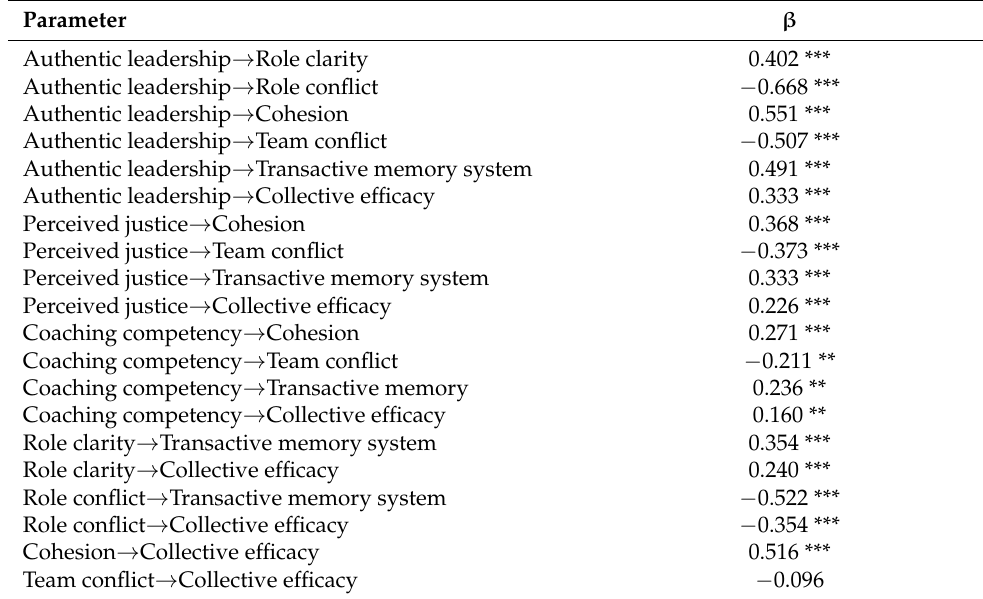
Table 3. Indirect effects of the different